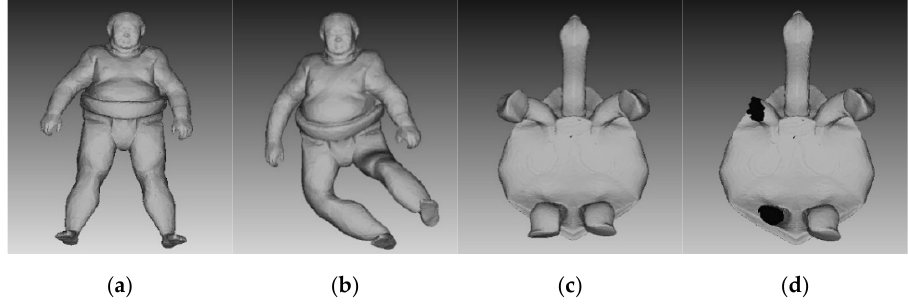
Figure 3. Original, deformed and partially removed 3D models; ( a ): original sumotori model; ( b ): deformed sumotori model; ( c ): original tortoise model; ( d ): partially removed tortoise model.